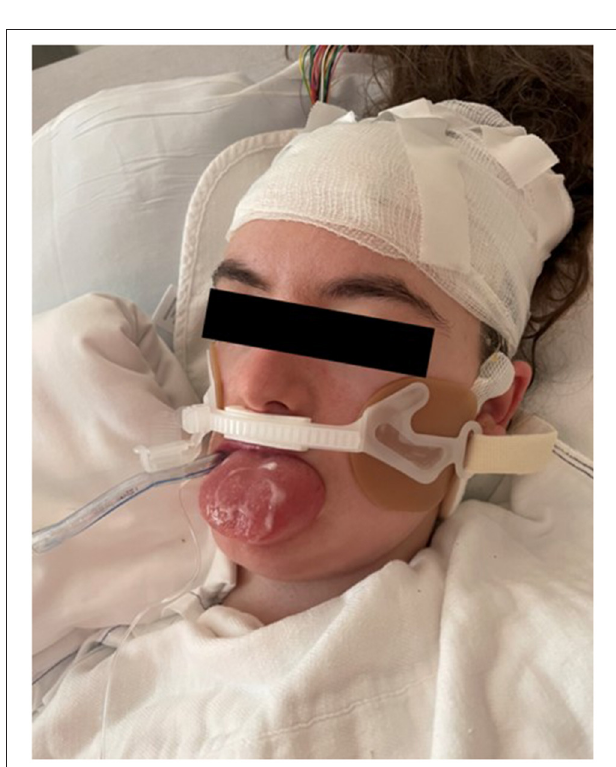
FIGURE 2 | Patient with notable tongue enlargement and protrusion from oral